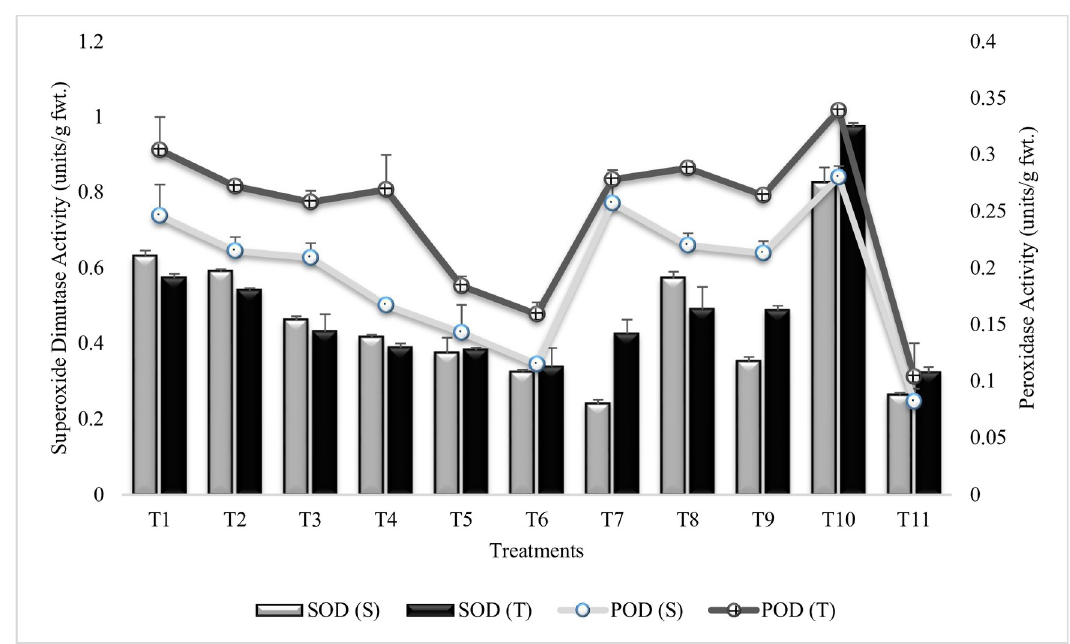
Fig 7. Superoxide dismutase and peroxidase activities of chickpea grown in sandy soil. Data are means of four replicates along with standard error bars (S-Sensitive Variety; T-Tolerant Variety).